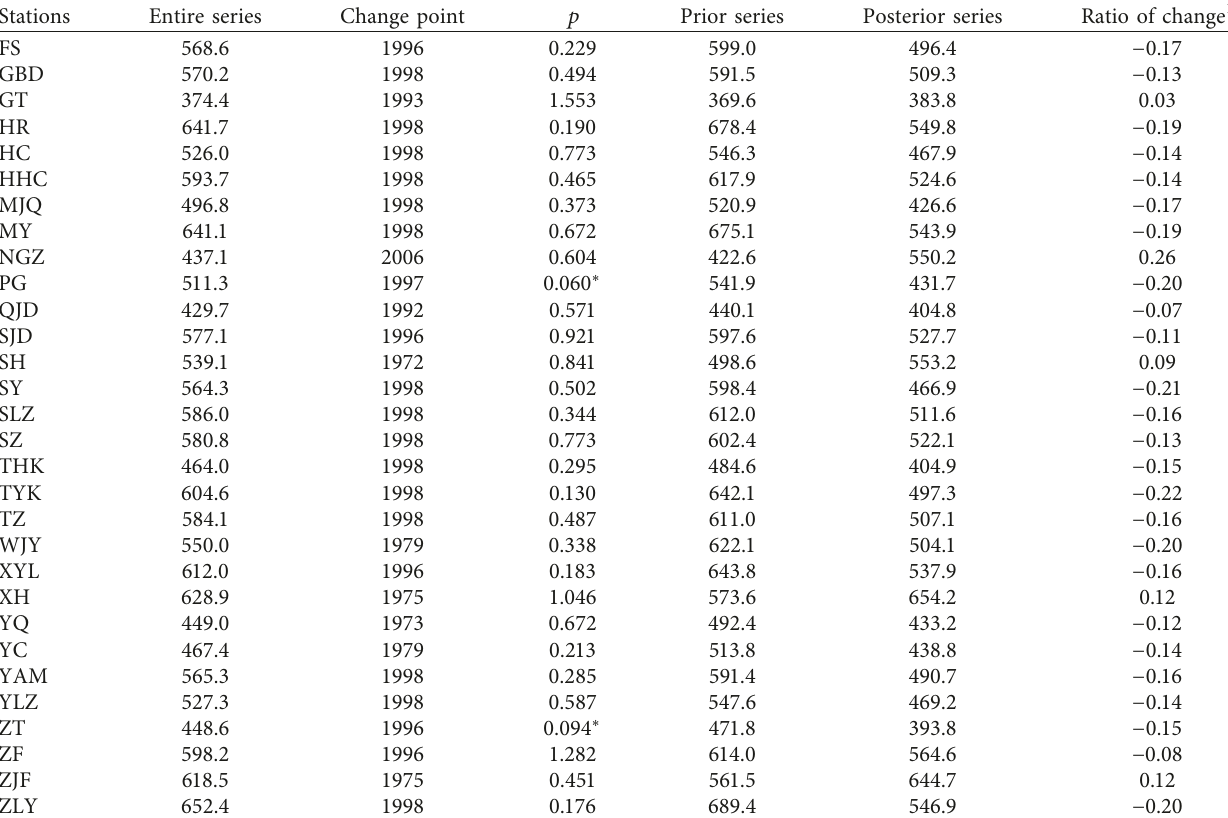
Table 5: Results of change-point detection for different stations based on the Pettitt test.